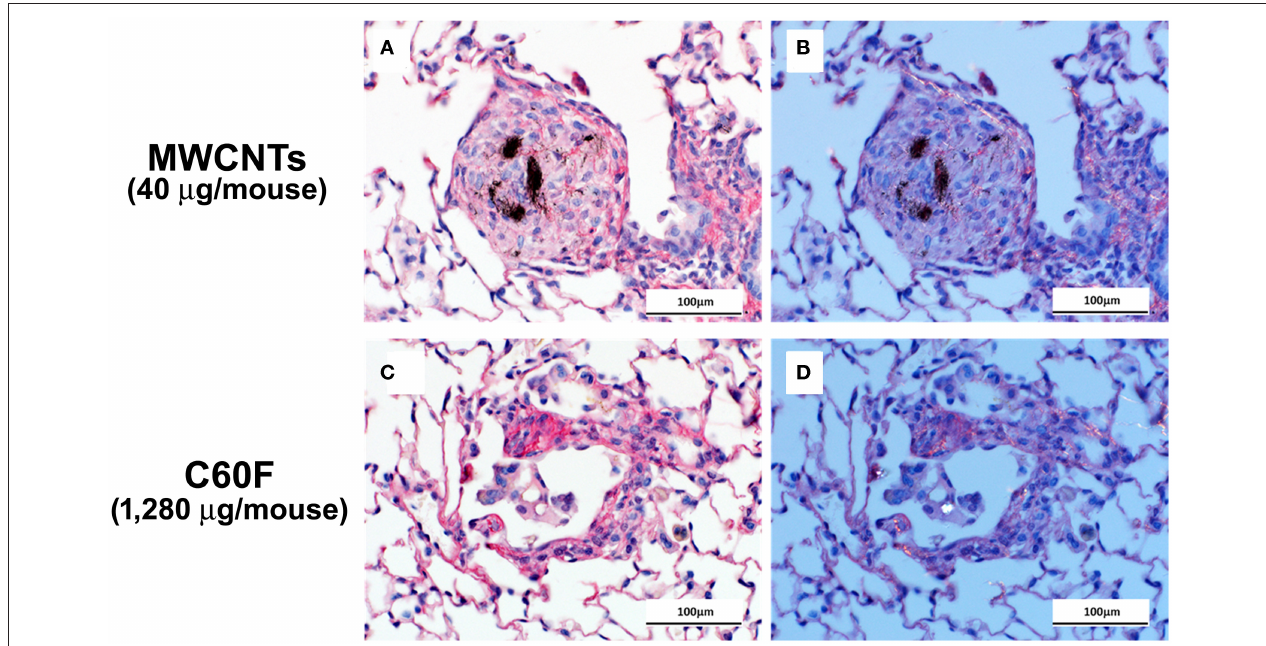
FIGURE 3 | Bright field and polarizing light microscopy images of picrosirius red-stained sections of lung. Mice were treated as described in Figure 2 legend and the lungs were examined at 28 day post-exposure. (A,C) show red staining of extracellular fibrils within a granuloma and in a focus of chronic inflammation. Polarization confirms the presence of collagen in (B,D) . Scale bar = 100 µ m.